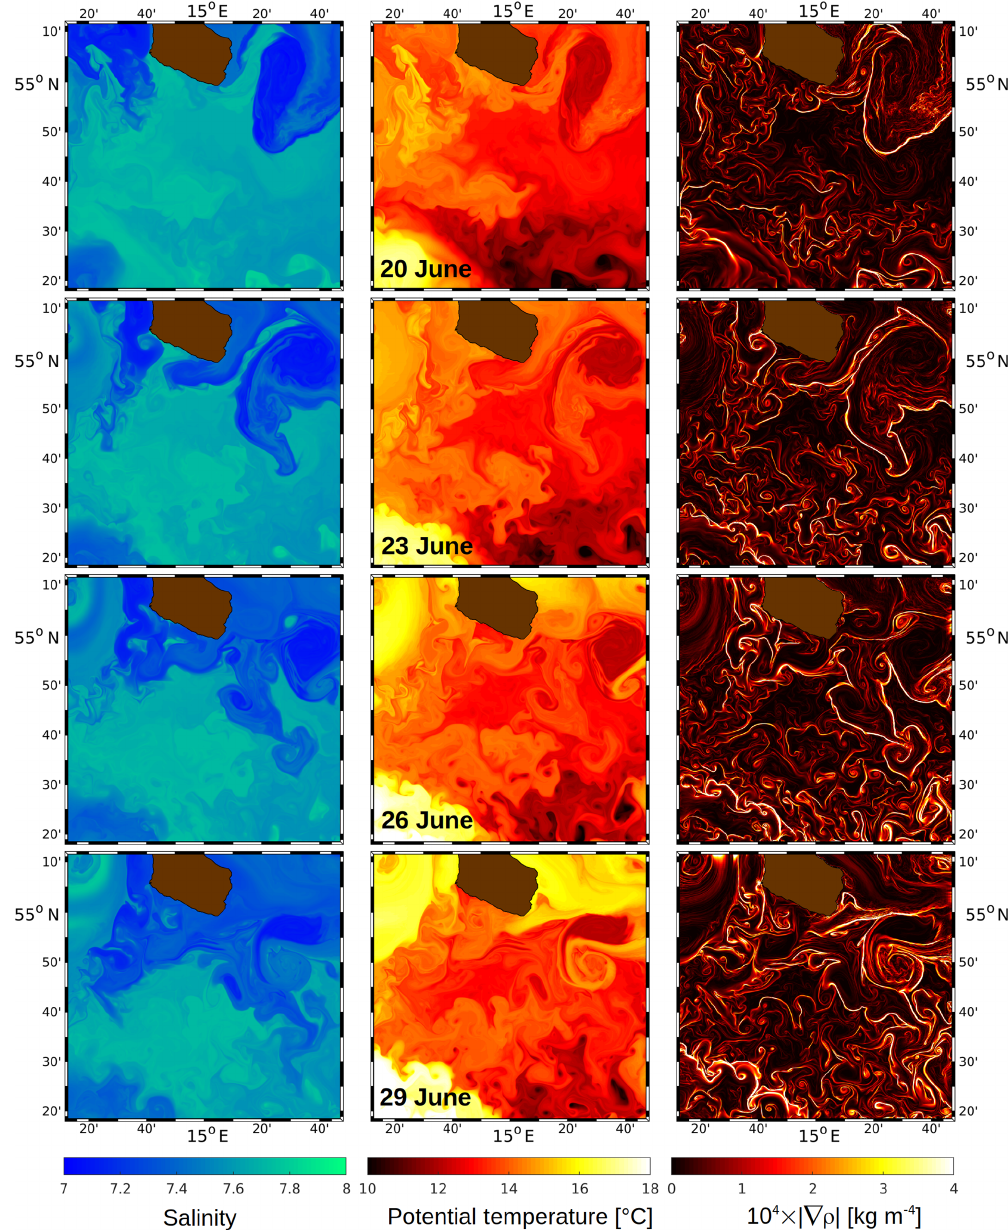
Figure 5. R100: top-layer salinity (left column), potential temperature (centre), and the absolute horizontal gradient of potential density (right) on 20, 23, 26, and 29 June. The upper end of the colour axis of |∇ ρ | is limited to 4 × 10 − 4 kgm − 4 to distinguish higher gradients from the dark